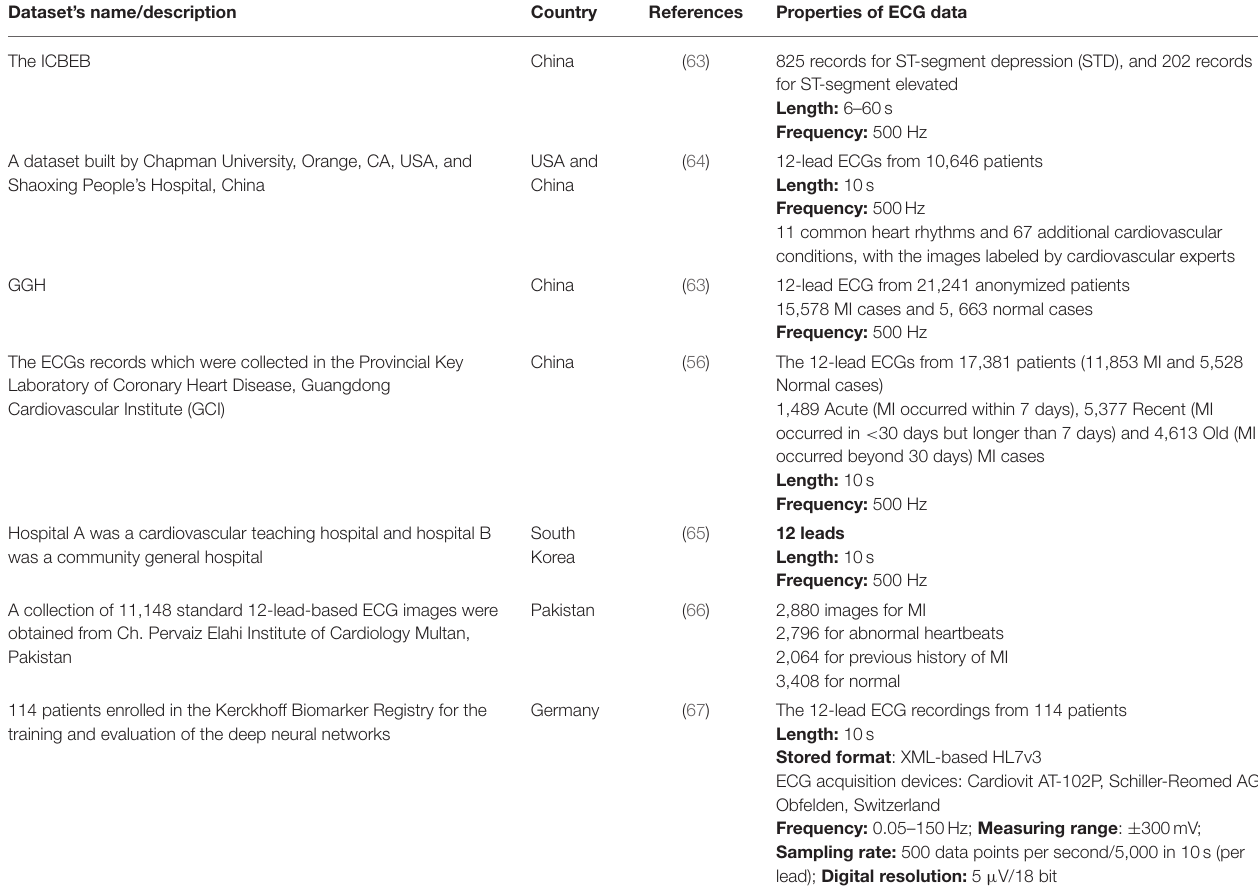
TABLE 3B | Description of newly collected datasets used in studied